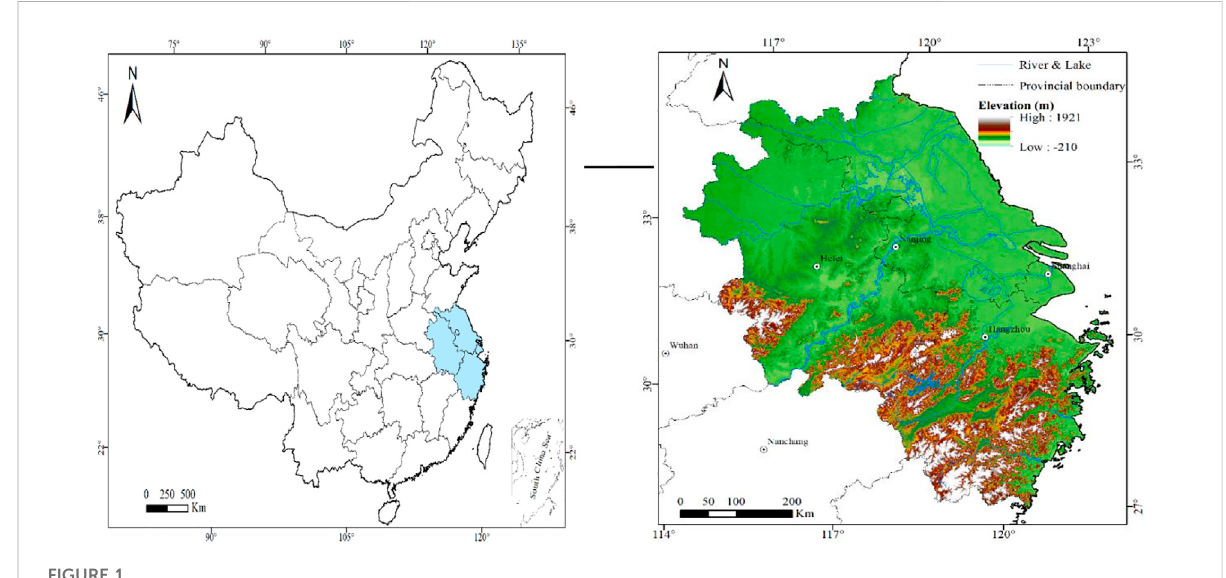
FIGURE 1 Location of the Yangtze River Delta region of